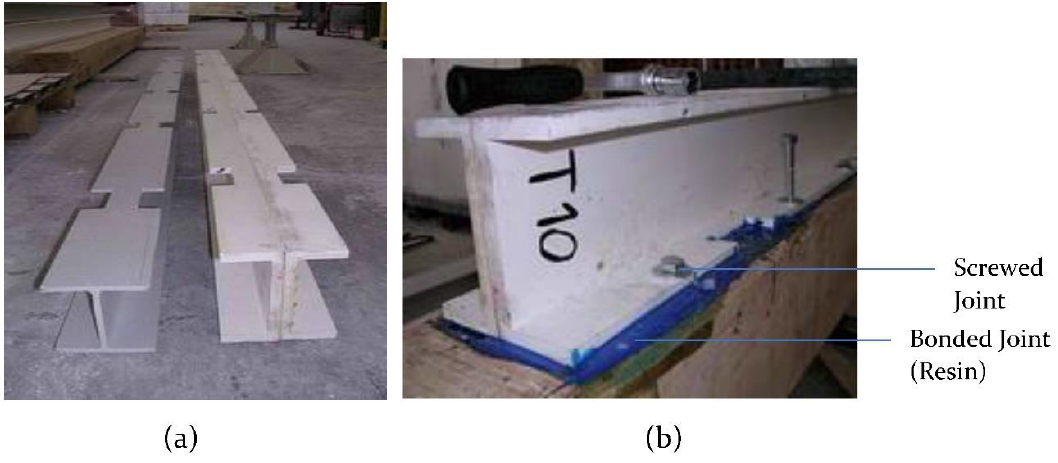
Figure 3. ( a ) H- and I-type GFRP profiles; ( b ) different joint methods used for GFRP application.